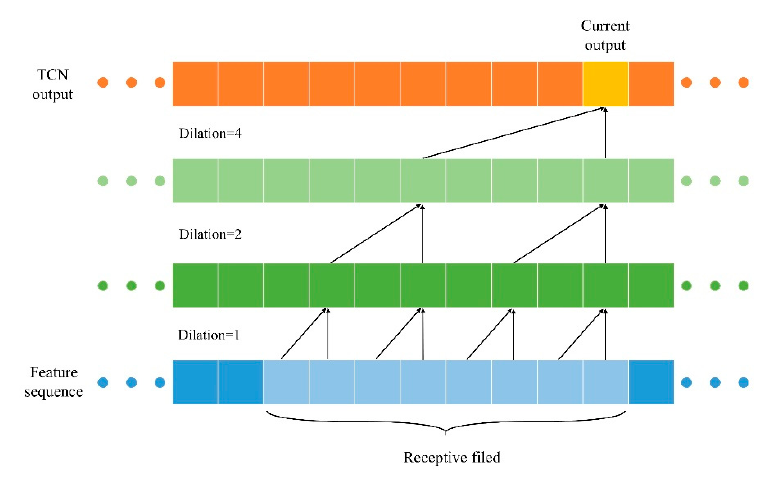
Figure 5. Simplified visualization of a TCN with kernel = 2, stack = 1, and dilation structure = [1, 2, 4].